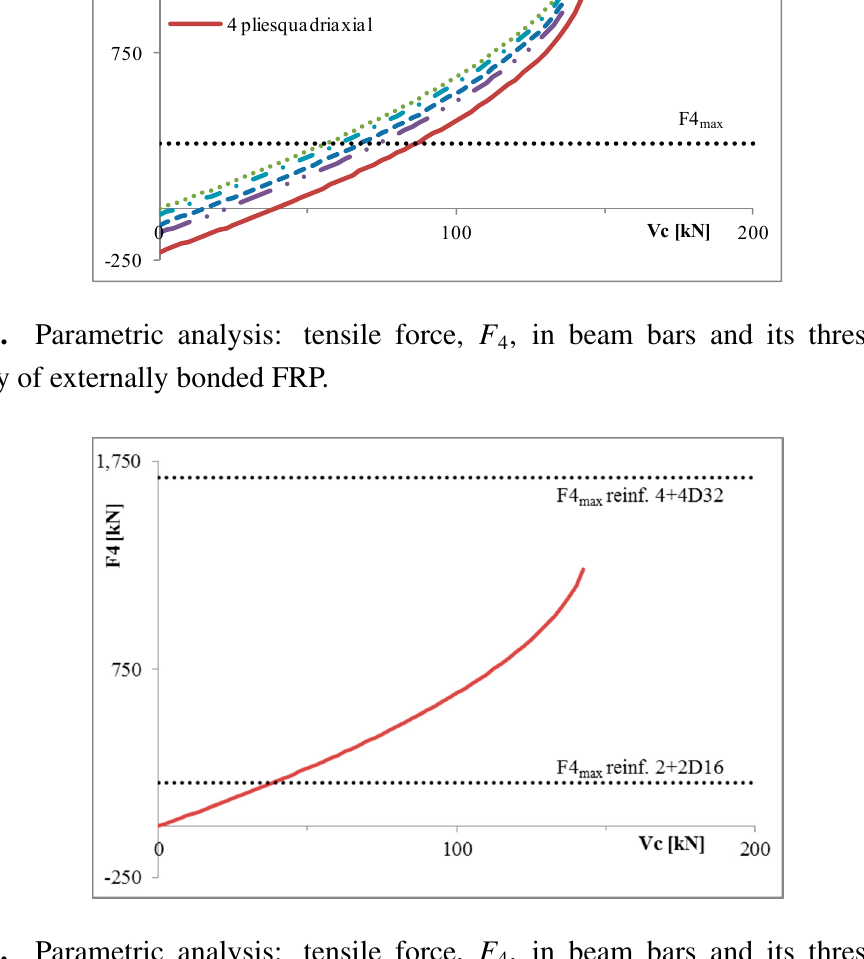
Figure 9. Parametric analysis: tensile force, F 4 , in beam bars and its threshold with variability of longitudinal beam reinforcement.